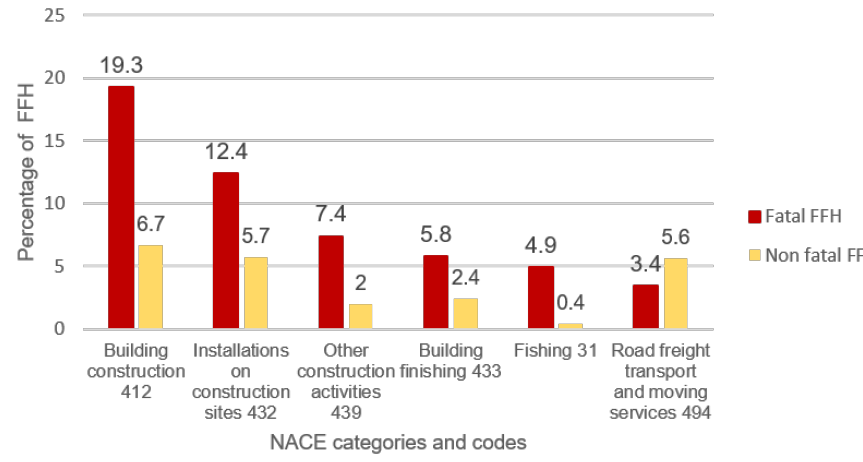
Figure 1. Distribution of Fatal and Non Fatal FFH by